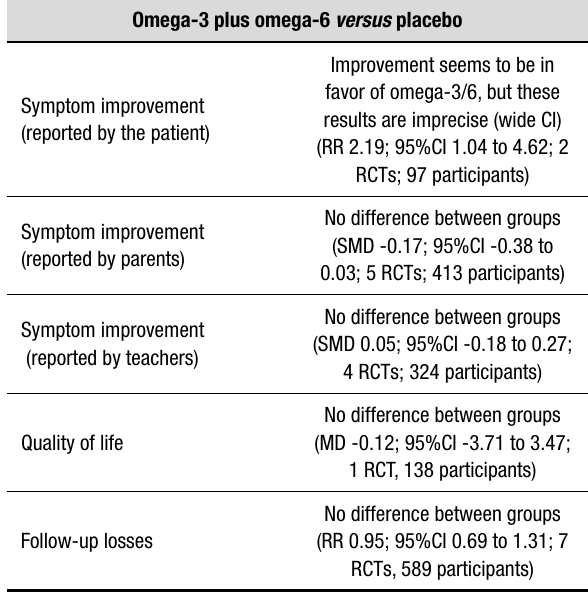
Table 3. Summary of the main outcomes: tricyclics for attention deficit hyperactivity